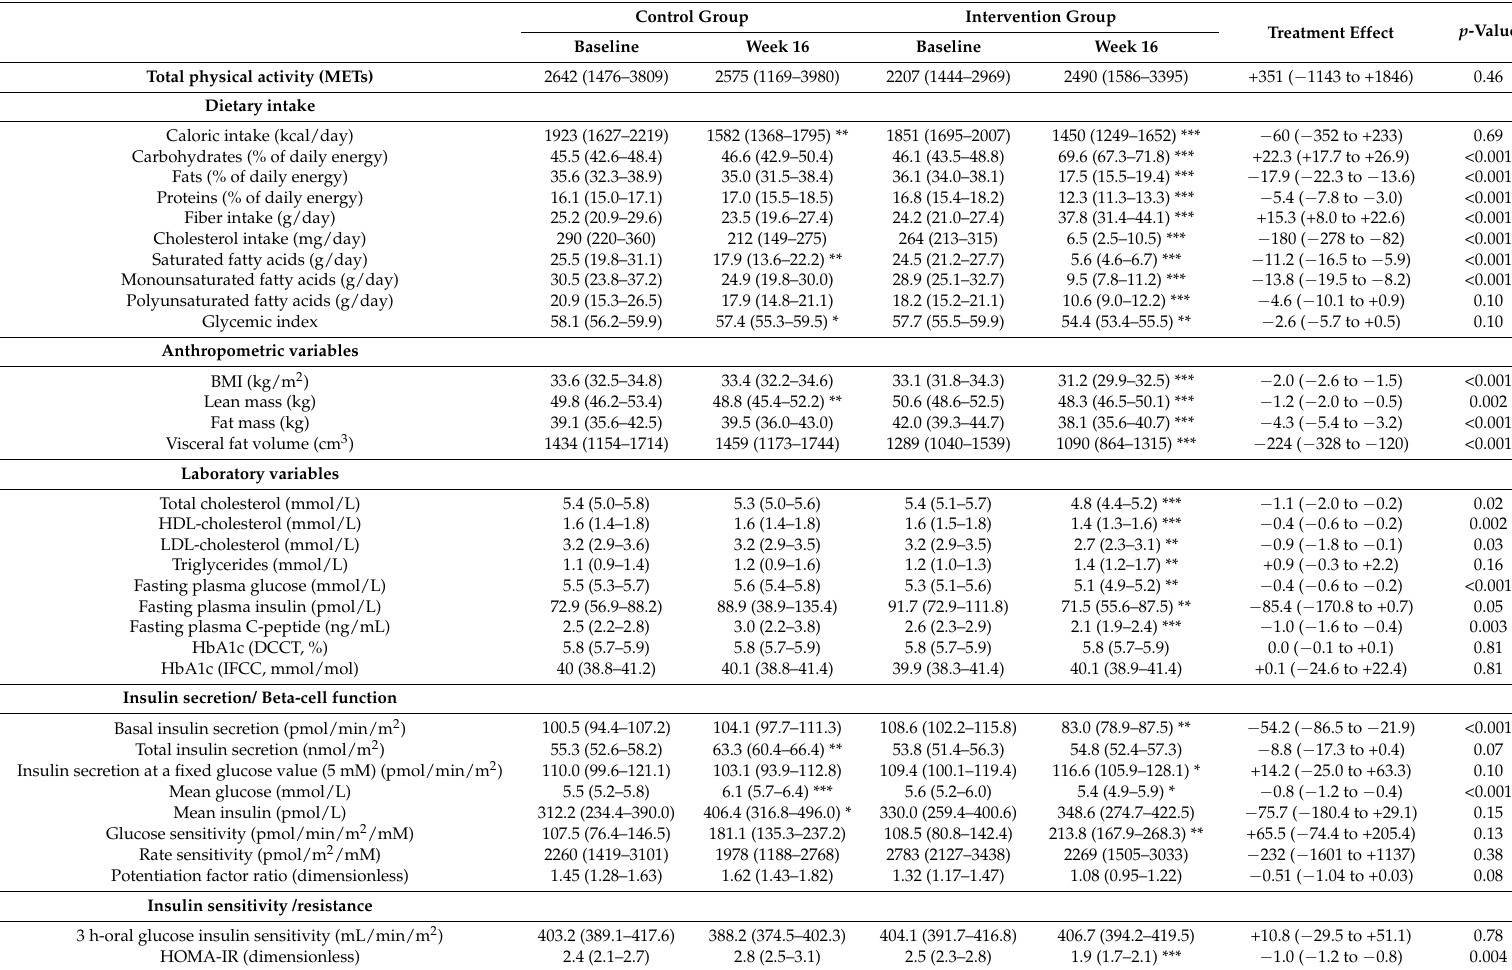
Table 2. Changes in dietary intake, clinical and laboratory variables during the study. Data are means ± SD. Listed p -values are for interactions between group and time assessed by repeated measures ANOVA. * p < 0.05, ** p < 0.01 and *** p < 0.001 for within-group changes from baseline assessed by paired comparison t